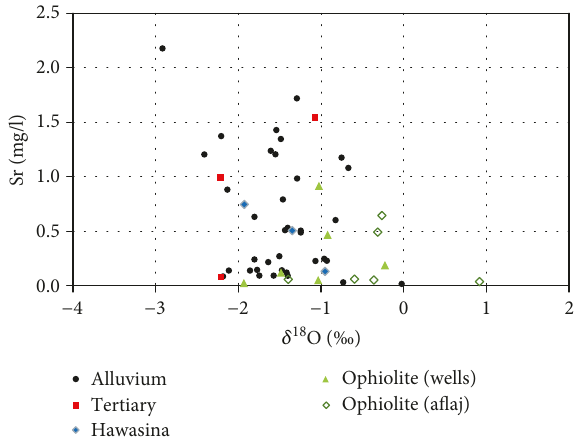
Figure 9: Correlation between the Sr concentration (mg/l) and δ 18O ‰ . The diagram shows a fair correlation, which indicates the change due to groundwater increasing residence time.